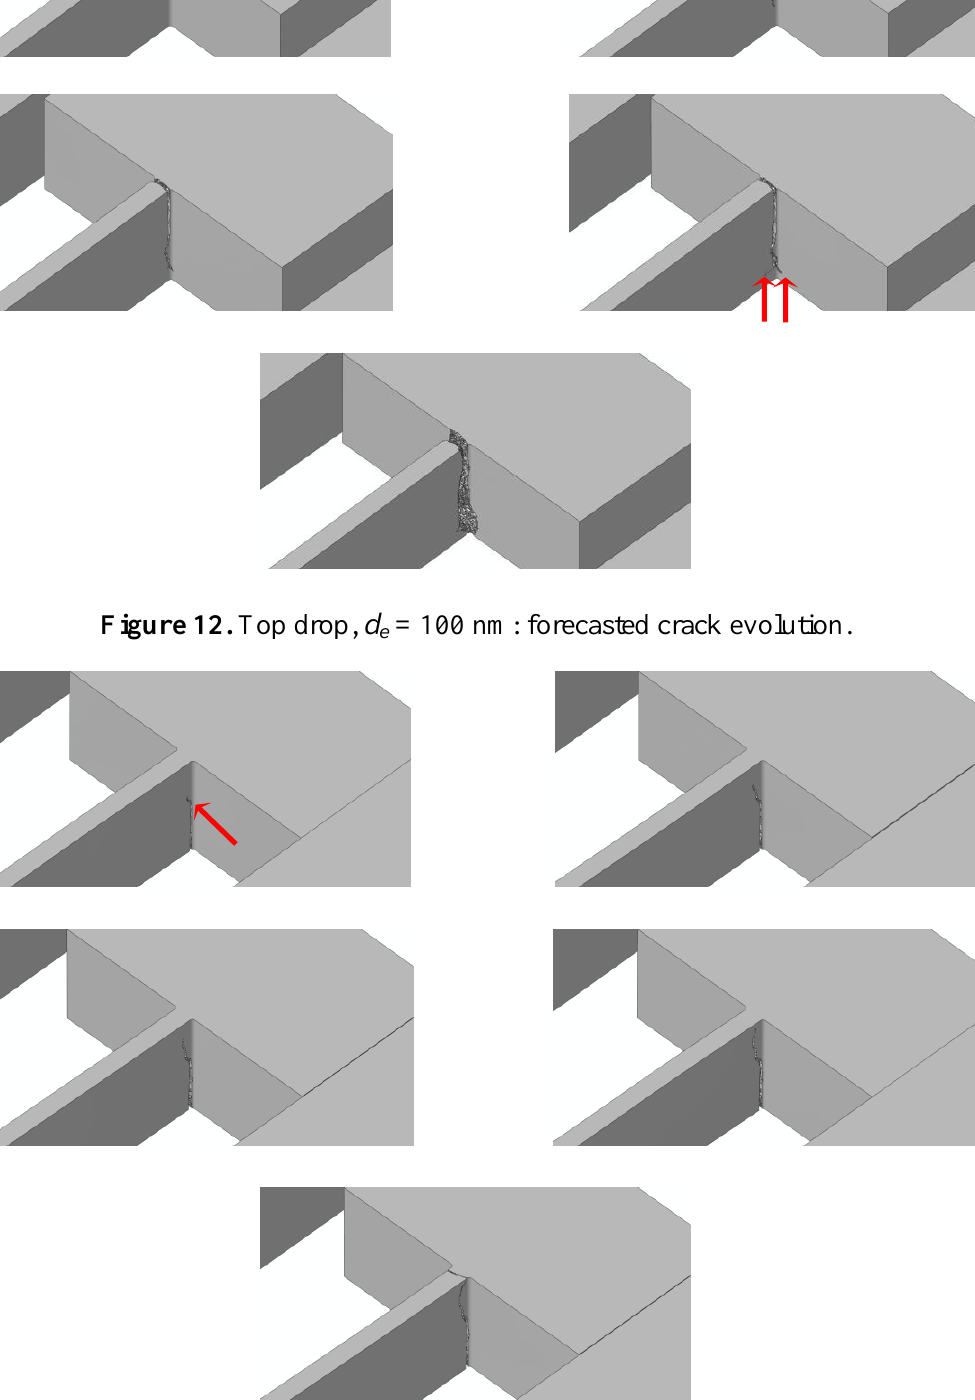
= 100 nm: forecasted crack evolution. e